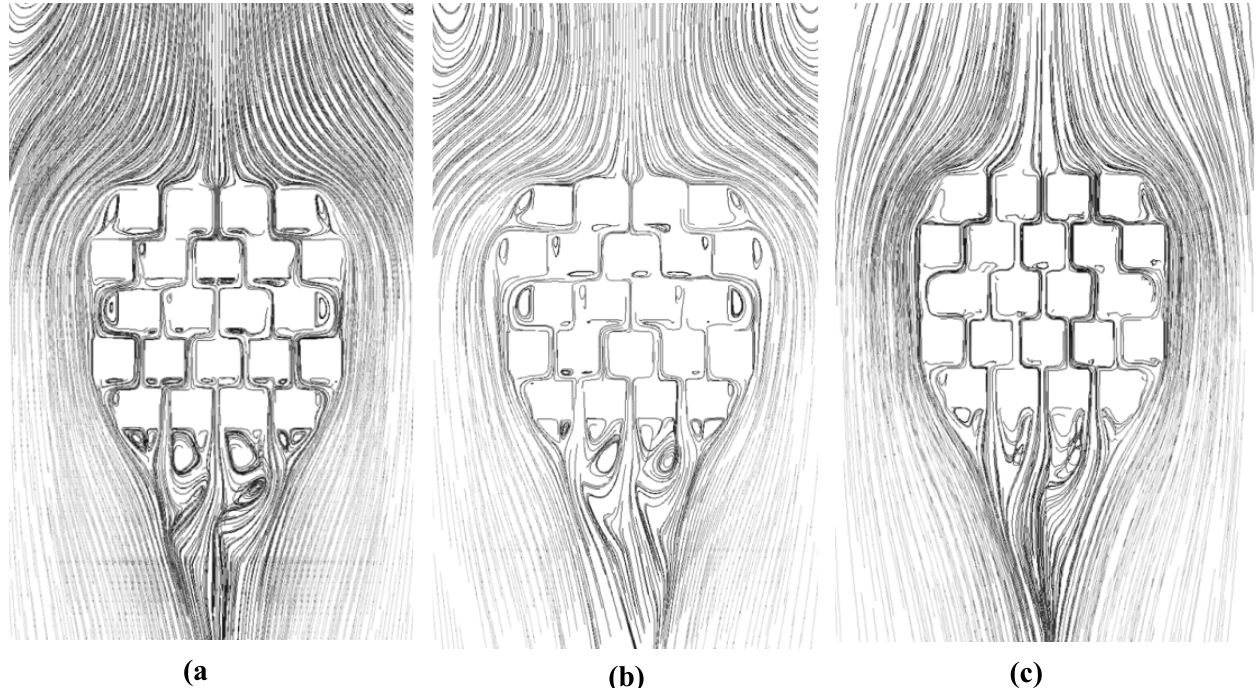
Fig. 10. Streamlines with different simulated turbulence models. (a) Standard k- ε ; (b) RNG; (c) realizable k-